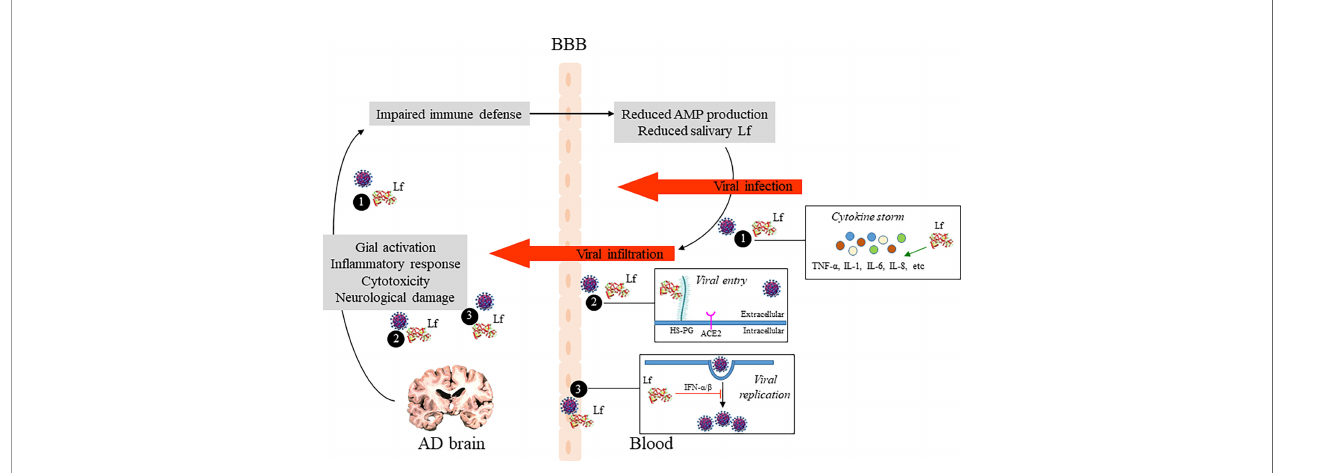
FIGURE 2 | Potential role of Lf in the relationship between AD brain pathology and COVID-19. Pathogenic events leading to neuronal damage may impair the host defense system which in turn reduce AMP production, including Lf, and in fl uence the extent of SARS-CoV-2 infection in the brain. Additionally, potential antiviral mechanisms of Lf are shown: (1) by modulating SARS-CoV-2 induced in fl amation, reducing pro-in fl ammatory cytokine levels, such as IL-6 and TNF a ; (2) by occupying binding sites of SARS-CoV-2, as heparan sulfate proteoglycans (HSPGs) on the host cell surface, reducing viral sur fi ng and subsequent viral entry; and (3) by inhibition of viral replication via induction of intracellular cell signals. AD, Alzheimer ’ s disease; Lf, lactoferrin; AMP, antimicrobial peptide; BBB, blood-brain